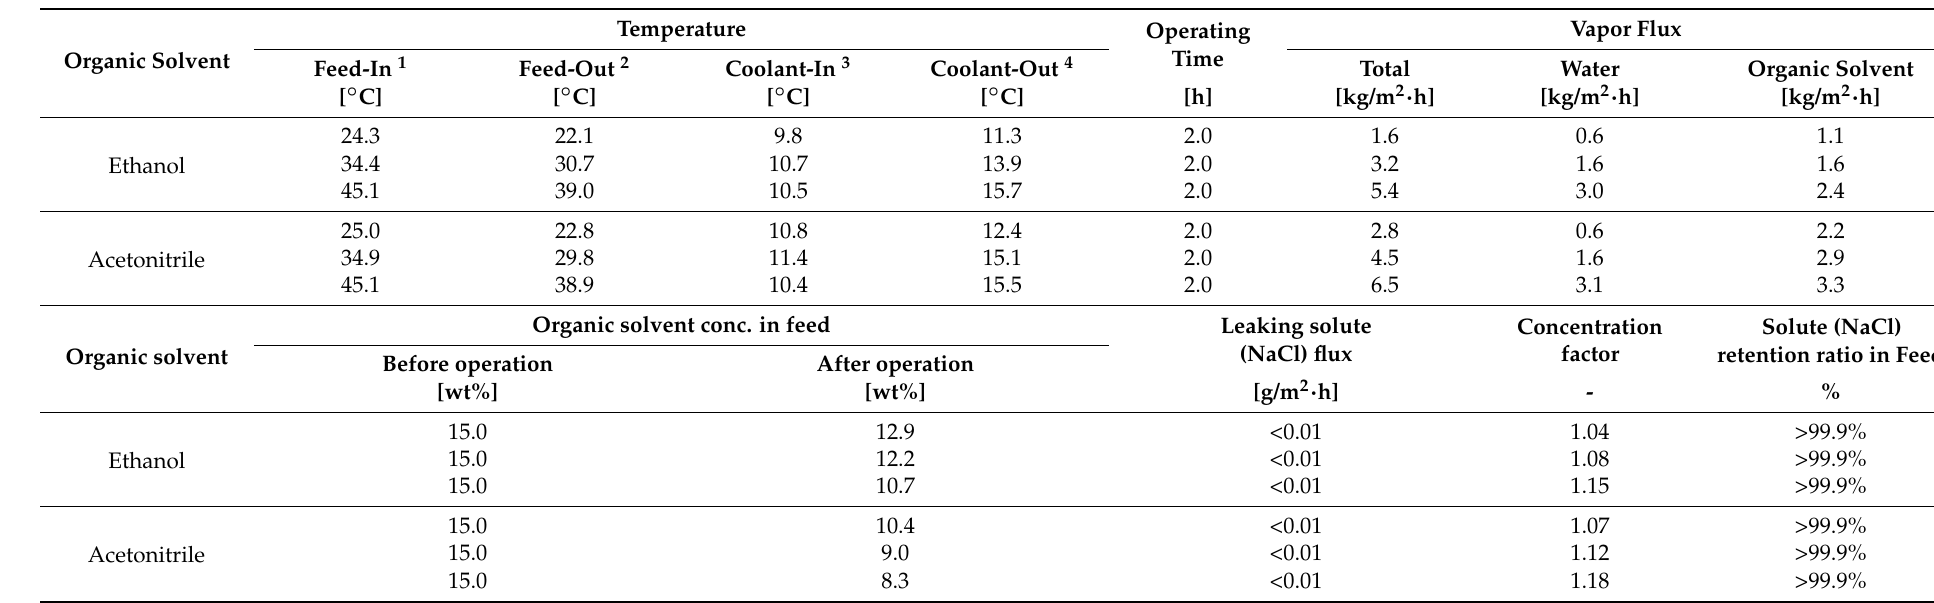
Table 3. Results of DCMD operation at various temperature with the feed which contains 1000 ppm NaCl and 15 wt% of ethanol or